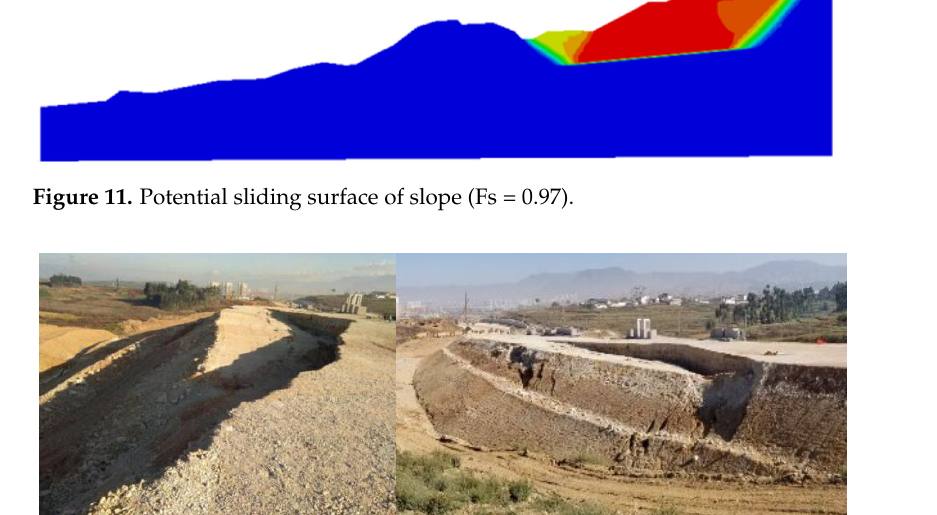
Table 5. Influence of the calculation method on the stability coefficient.